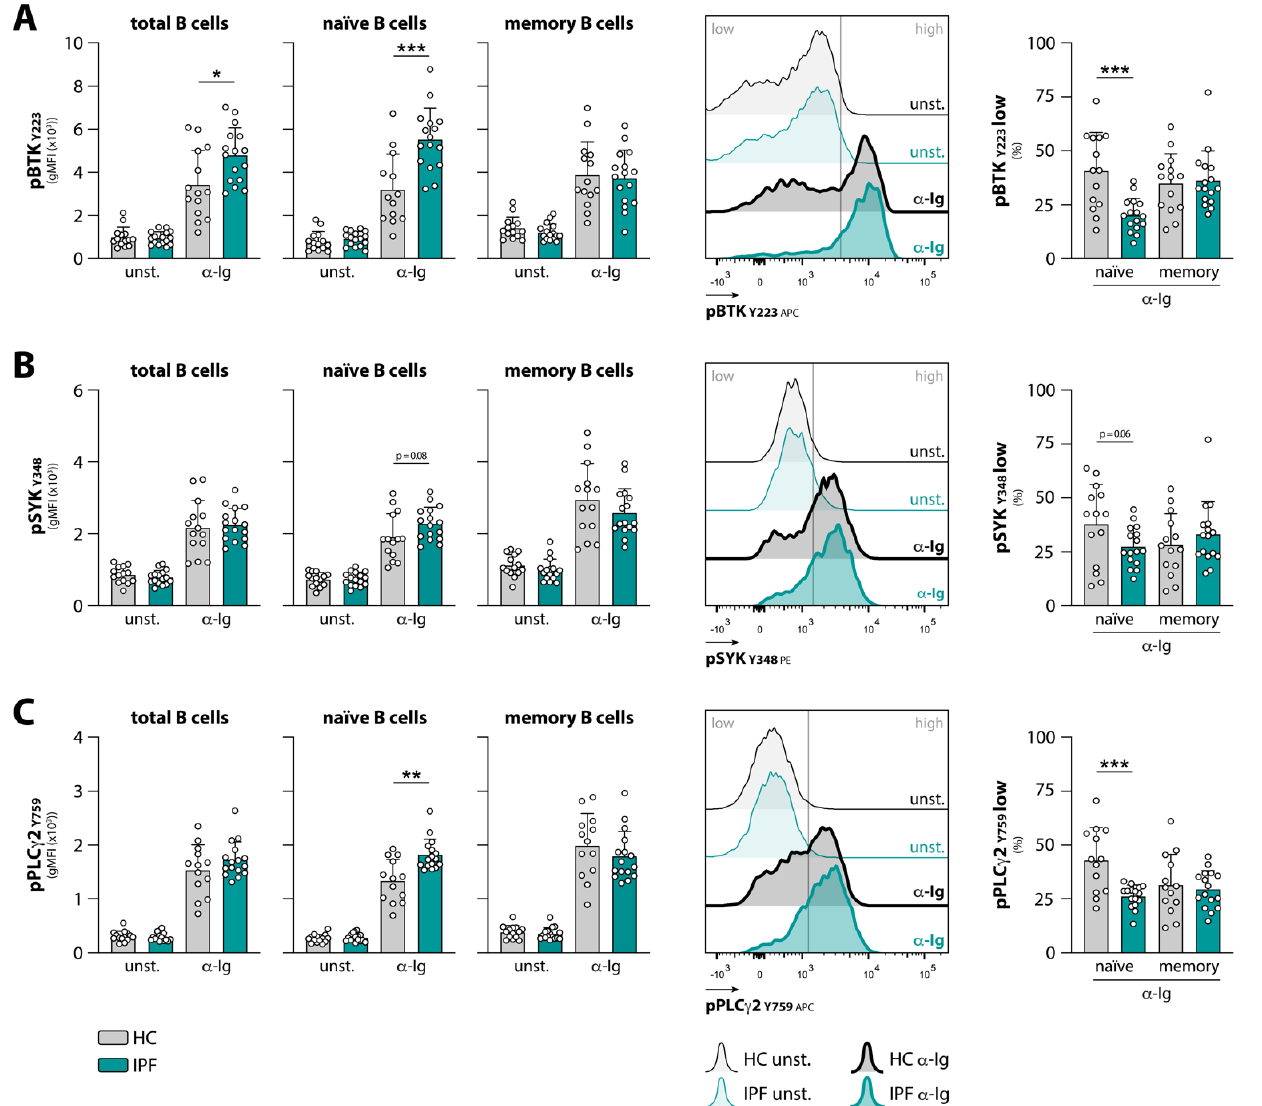
Figure 1. Phosphoflow analysis of BCR downstream signaling molecules in peripheral blood B cells from HCs and IPF patients (cohort 1). ( A – C ) Phosphorylation levels, expressed as geometric mean fluorescence intensity (gMFI) under unstimulated (unst.) conditions and after BCR stimulation (anti-immunoglobulin; α -Ig) in total (CD3 − CD19 + IgM +/ − ), naïve (CD3 − CD19 + CD38 lo CD27 − IgD + ; 56.8% ± 15.4 in HCs and 69.0% ± 11.0 in IPF patients of total B cells), and memory (CD3 − CD19 + CD38 lo CD27 + ; 23.6% ± 5.8 in HCs and 21.7% ± 6.2 in IPF patients of total B cells) B cells from HCs and IPF patients for ( A ) pBTK Y223 , ( B ) pSYK Y348 , and ( C ) pPLC γ 2 Y759 ( left panel ). Representative histograms are shown with the gray vertical line indicating the gate for selecting the population low/high in phosphorylation following α -Ig stimulation ( middle panel ). Proportions of ( A ) pBTK-low, ( B ) pSYK-low, and ( C ) pPLC γ 2-low cells, expressed as percentage of total naïve or memory B cell fraction ( right panel ). Subjects are indicated by individual data points, and bars indicate mean values + SD. * p < 0.05, ** p < 0.01, *** p < 0.001 in (( A – C ) (right panel)) by an unpaired two-tailed Student’s t -test or (in ( C ) (left panel)) by a Mann–Whitney U .